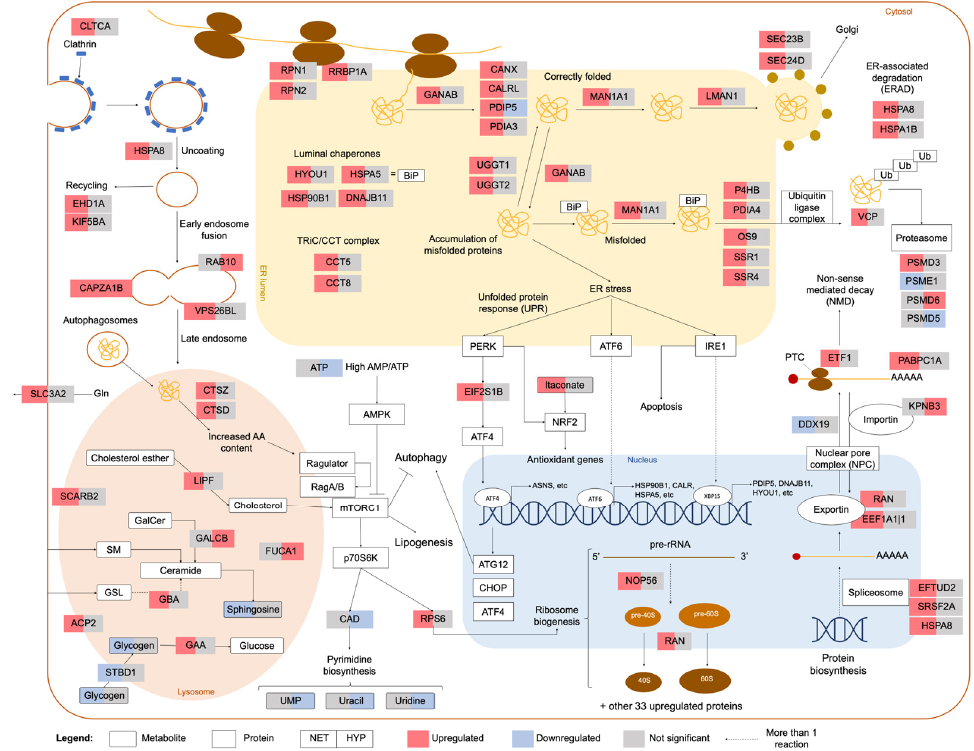
Figure 5. Overview of the cellular processes and signaling pathways affected by net handling and hypoxia in gilthead seabream hepatocytes. The proteins and metabolites represented were differentially different in abundance, according to a Student’s t -test with FDR controlled at 0.05. The ERAD system mediates the removal of incorrectly folded proteins in a multistep process involving the recognition and targeting of substrates, followed by ubiquitination, retrotranslocation, and degradation [40]. After ubiquitination, protein recycling can occur through autophagy and/or the ubiquitin-proteasome system (UPS) [41]. NET fish presented 12 proteins involved in the ERAD process that were found to be upregulated, suggesting that protein degradation was stimulated in challenged fish. Nevertheless, two proteins belonging to the proteasome showed ambiguous expression patterns (PSMD3 was upregulated, whereas PSME1 was downregulated). The same was verified for HYP fish (PSMD6 was upregulated, whereas PSMD5 was downregulated) (Figure 5). In OC fish, proteasome subunit beta type-6 (PSMB6) was upregulated. Changes in proteasome subunits were reported in Atlantic cod in response to V. anguillarum infection [42] and high- temperature exposure [43]. Interestingly, heat-shock protein family A (Hsp70) member 8 (HSPA8), an upregulated protein in NET-challenged fish’s ERAD response, is involved in a process called “chaperone-mediated autophagy”, which entails the direct delivery of cytosolic proteins, targeted for degradation, to the lysosomes. However, this cellular function has been poorly described in fish because, until recently, it was presumed to be exclusive to mammals and birds [44,45]. Moreover, the upregulation of HSPA8 was also observed in Senegalese sole following repeated handling stress [46] and in gilthead seabream fed maslinic-supplemented diets